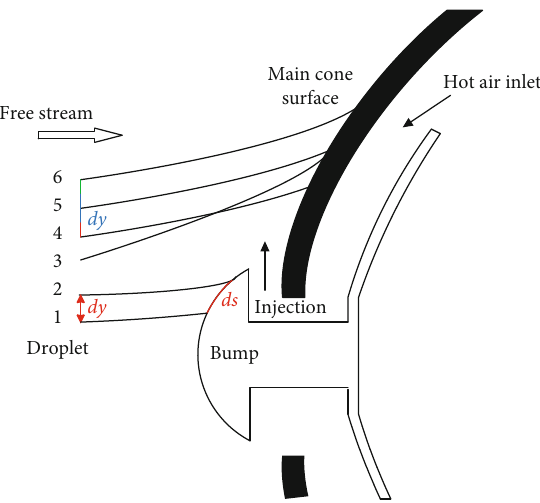
Figure 1: Droplet trajectories and collection e ffi ciency under upstream e ff